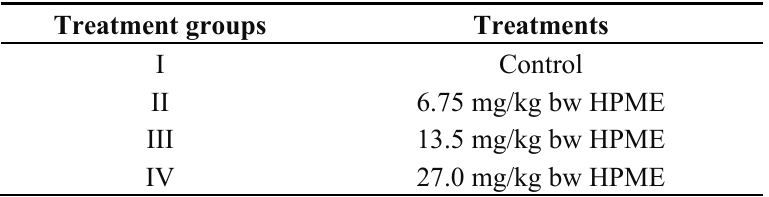
Table 1. Experimental